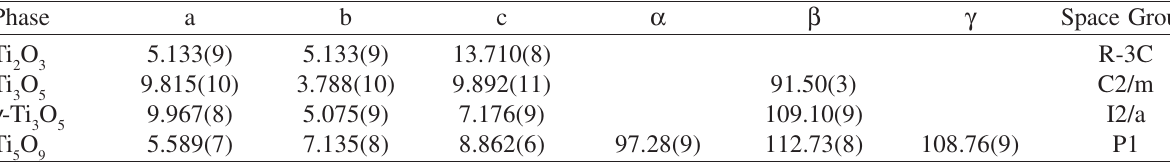
Table 3. Mean unit-cell parameters of titanium oxides obtained in the refinement